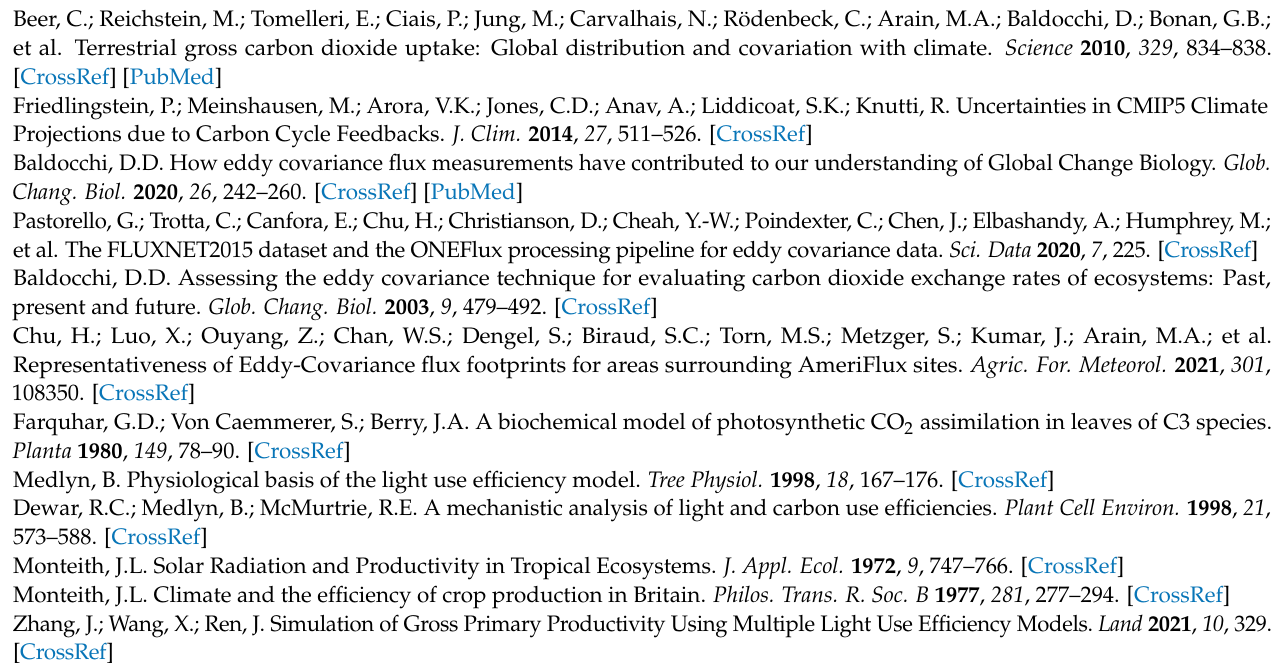
Figure A2. Model validation, GPP simulations versus eddy-covariance estimates; companion to Figure 2 (main text), but restricted to those sites deemed to show spatial homogeneity of vegetation cover. Forcing temperature is Sentinel3 LST. The intensity of the colours (heat-map) is designed to indicate the density of points. Each point is a ten-day average. The dashed-grey line shows the ideal fit.